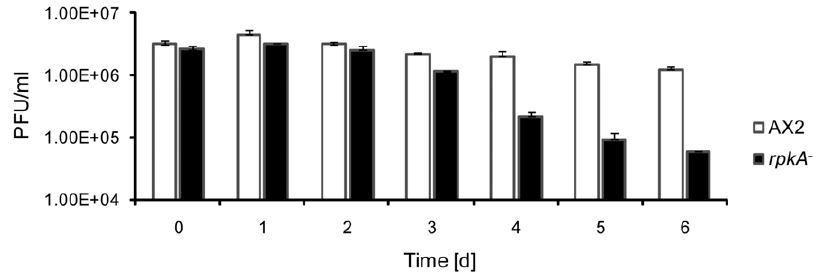
Figure 7. rpkA 2 cells show reduced tolerance against nitrogen starvation. AX2 and rpkA 2 cells were grown in FM-Medium for at least 5 generations, harvested during the exponential growth phase and resuspended at a density of , 3 6 10 6 cells/ml in FM medium lacking amino acids. At the indicated time points viability was determined by analyzing the ability to form colonies (PFU, plaque forming units) on bacterial lawns. Results are provided for duplicate experiments with duplicate samples 6